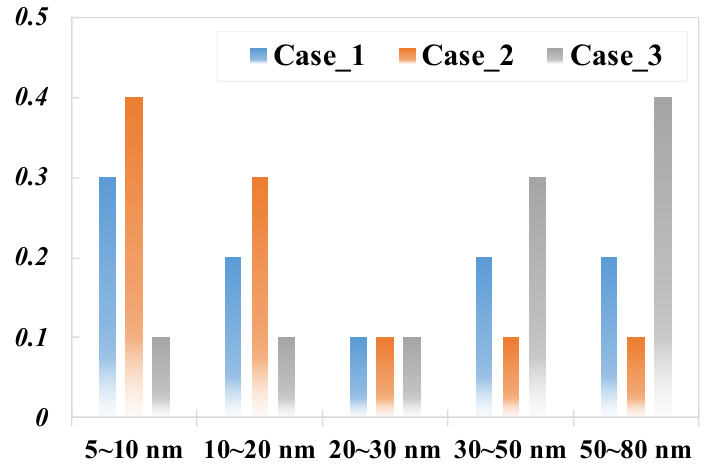
Figure 6. Different pore size distributions of the nanoscale porous media.